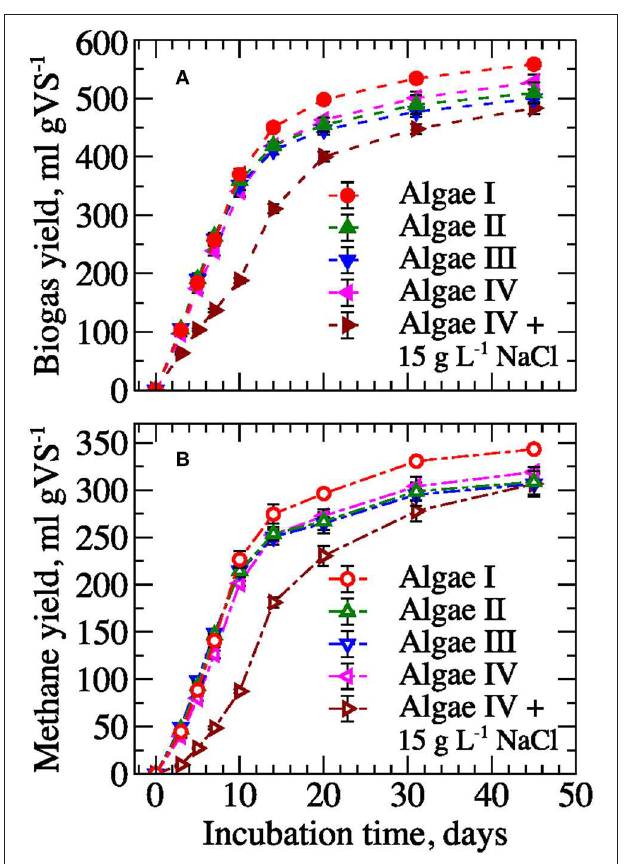
FIGURE 3 | Specific biogas (A) and methane (B) yields from filamentous algal biomass (mean ± 1 S.D. of three replicates).